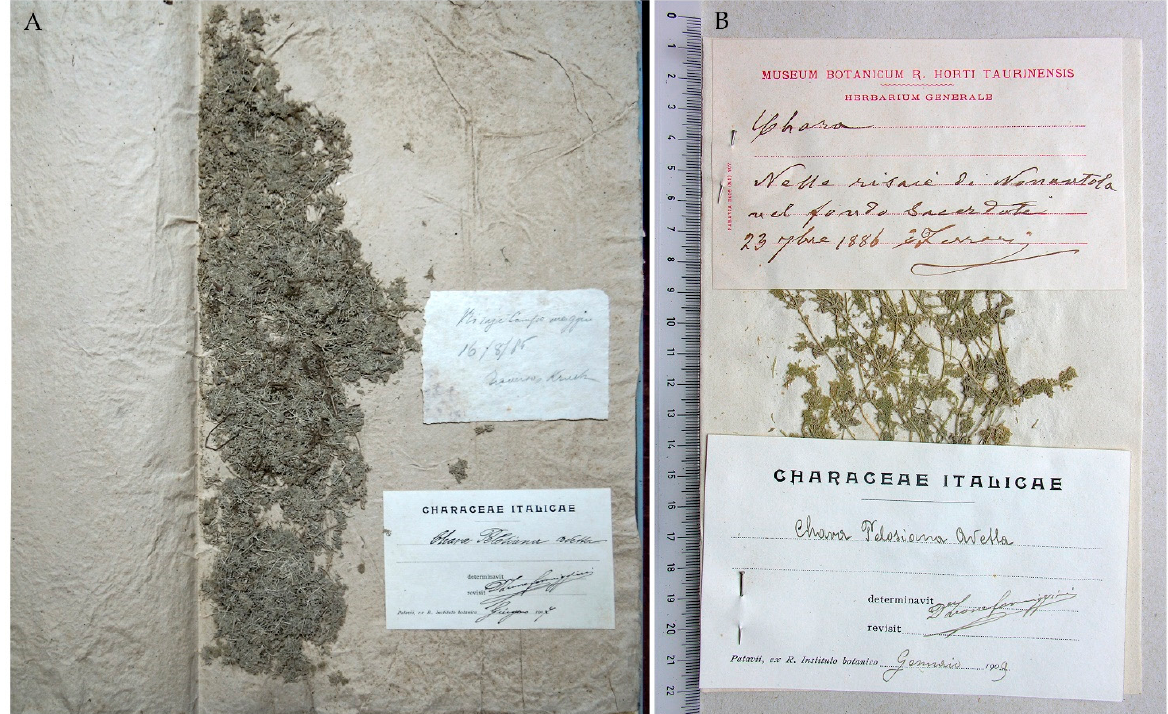
Figure 5. Unpublished specimens of Chara pelosiana . ( A ) PAV specimen collected by Traverso and Kruch from Campo